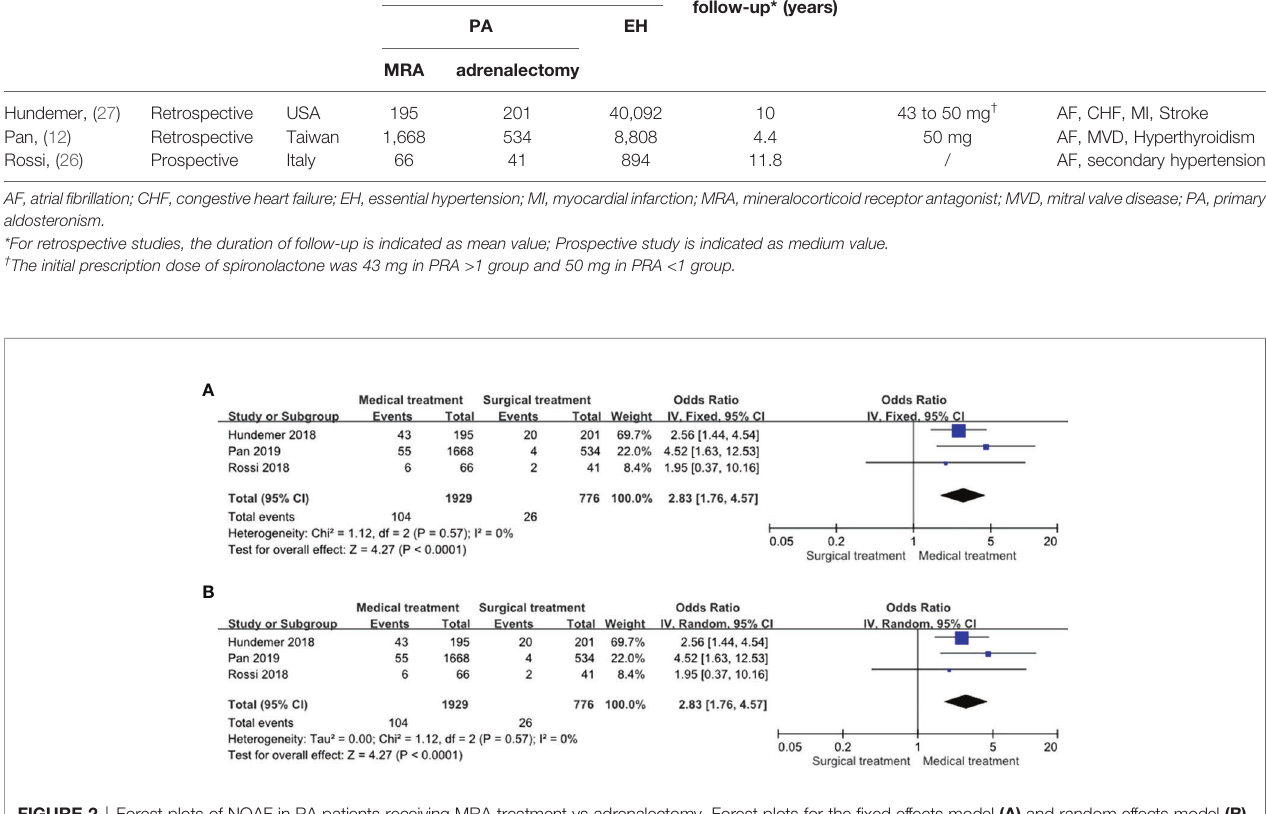
FIGURE 2 | Forest plots of NOAF in PA patients receiving MRA treatment vs adrenalectomy. Forest plots for the fi xed effects model (A) and random effects model (B) . CI, con fi dence interval; OR, odds ratio; NOAF, new-onset atrial fi brillation; PA, primary aldosteronism; MRA, mineralocorticoid receptor